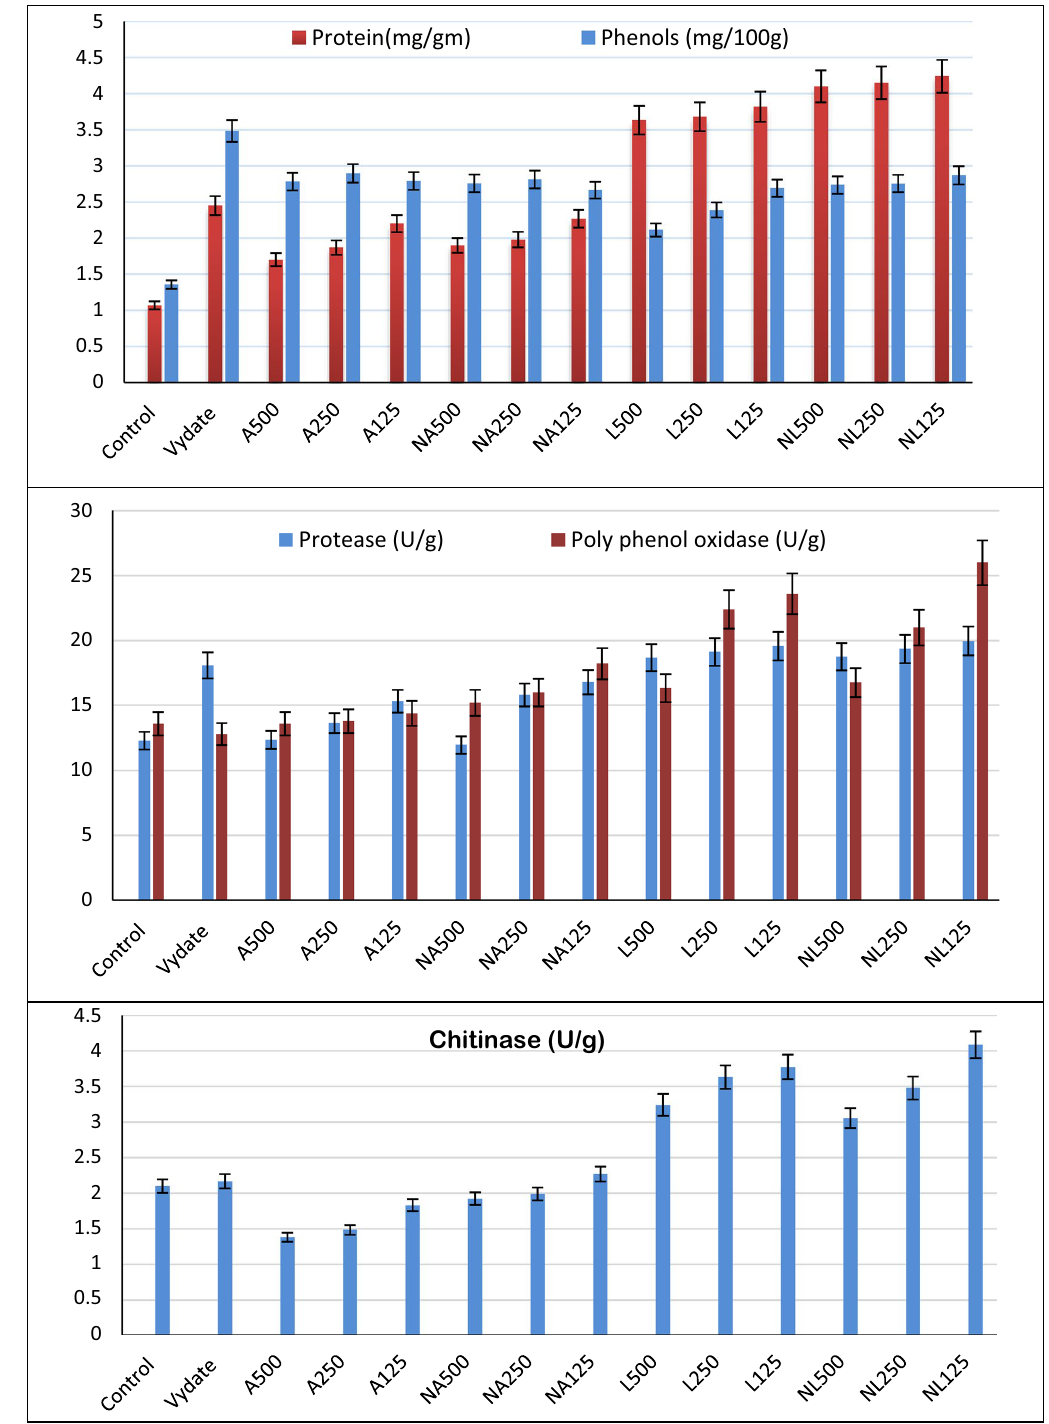
Figure 2. Effect of A. annua and L. sativum extracts and their nano-formulations on biochemical parameters of tomato leaves infected with M. effective in increasing total phenolics in leaves. In comparison to the untreated control, the A. annua extract and their nano-formulations obtained a high level of total phenolics in tomato leaves. The same trend was observed for L. sativum , which had a high level of total phenolics in leaves in all treatments compared to the untreated control. According to the findings of this investigation, both extracts increased the total phenolic levels when compared to the control treatment. In general, total phenolics were varied in narrow range between 2.7 and 2.9 mg/g for A. annua treated plants, while it varied between 2.1 and 2.9 mg/100 g for L. sativum treated plants.